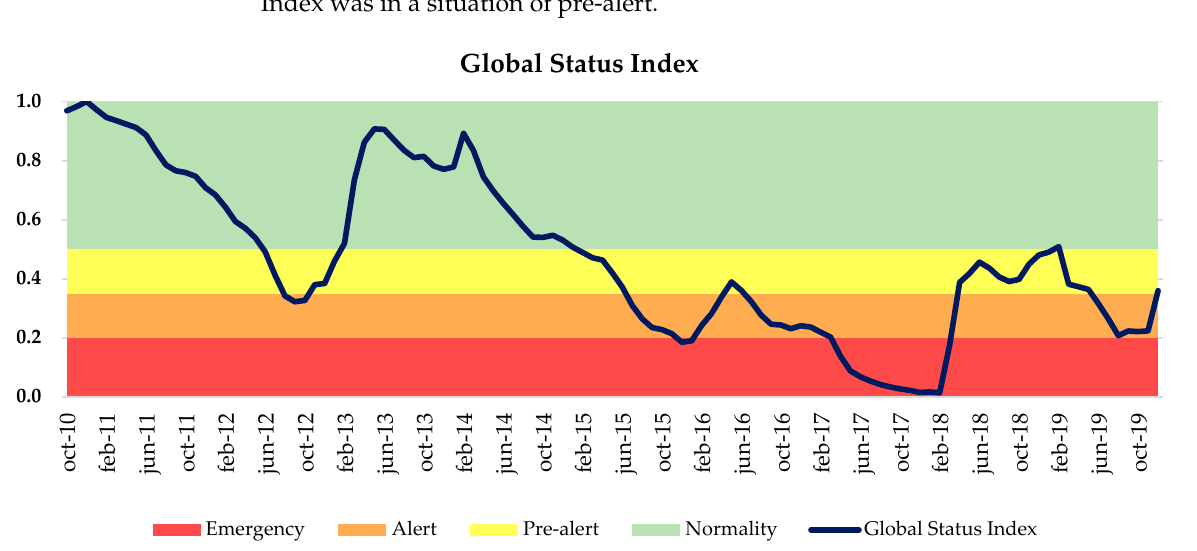
Figure 8. Evolution of the Global Status Index, period October 2010-December 2019. Source: own elaboration based on [63].